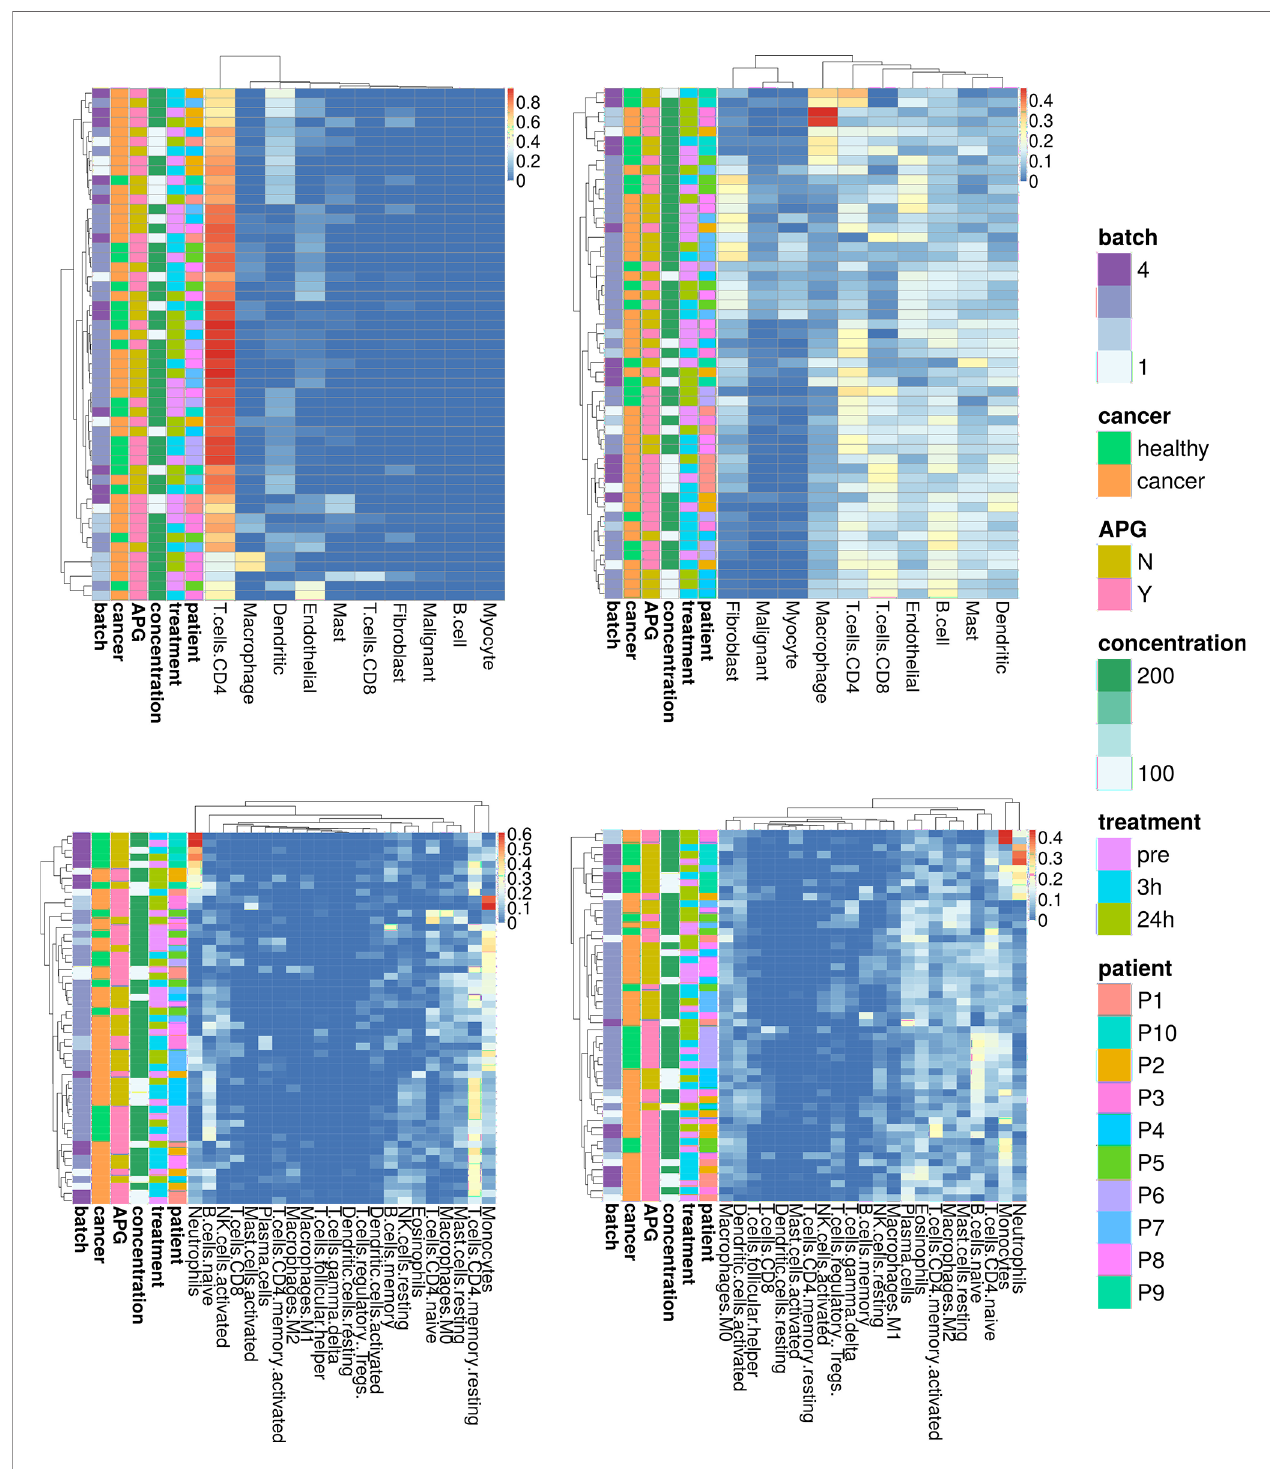
FIGURE 2 | Cell-type deconvolution from plasma cfRNA using two reference datasets and two deconvolution tools. Upper panel: a single cell RNAseq reference dataset from H&N cancer (28). Lower panel contains a reference from lymphocytes LM22 (27). Left panel shows results obtained by CIBERSORTx, right panel results obtained by GEDIT. Results are clustered by proximity. Each row represents a single sample, and an annotation panel is included to the left of each heatmap representing the: sequencing batch (batch), whether the patient has cancer (cancer), whether they received APG-157 (APG), which concentration (concentration), when the sample was collected (treatment) and the blinded patient ID. Some samples contain within batch/across batch technical